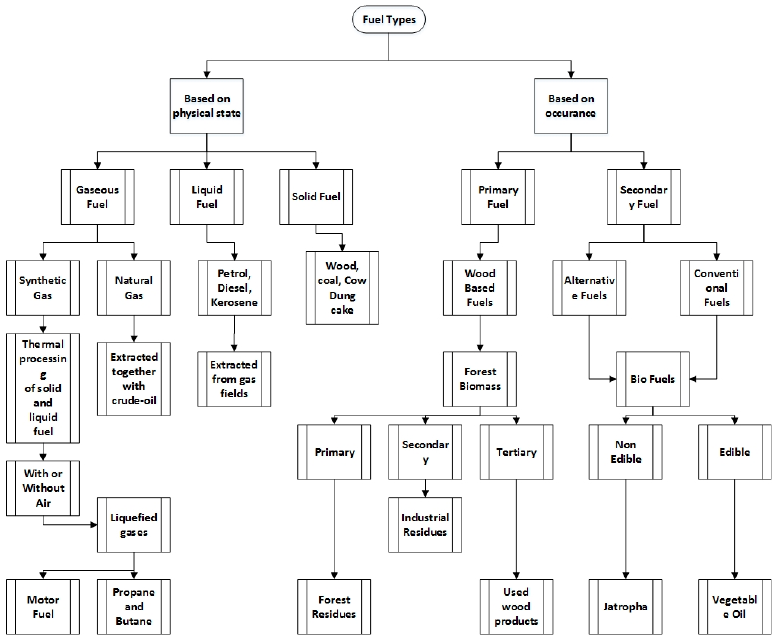
Figure 1. Classification of fuels based on their physical state and occurrence .